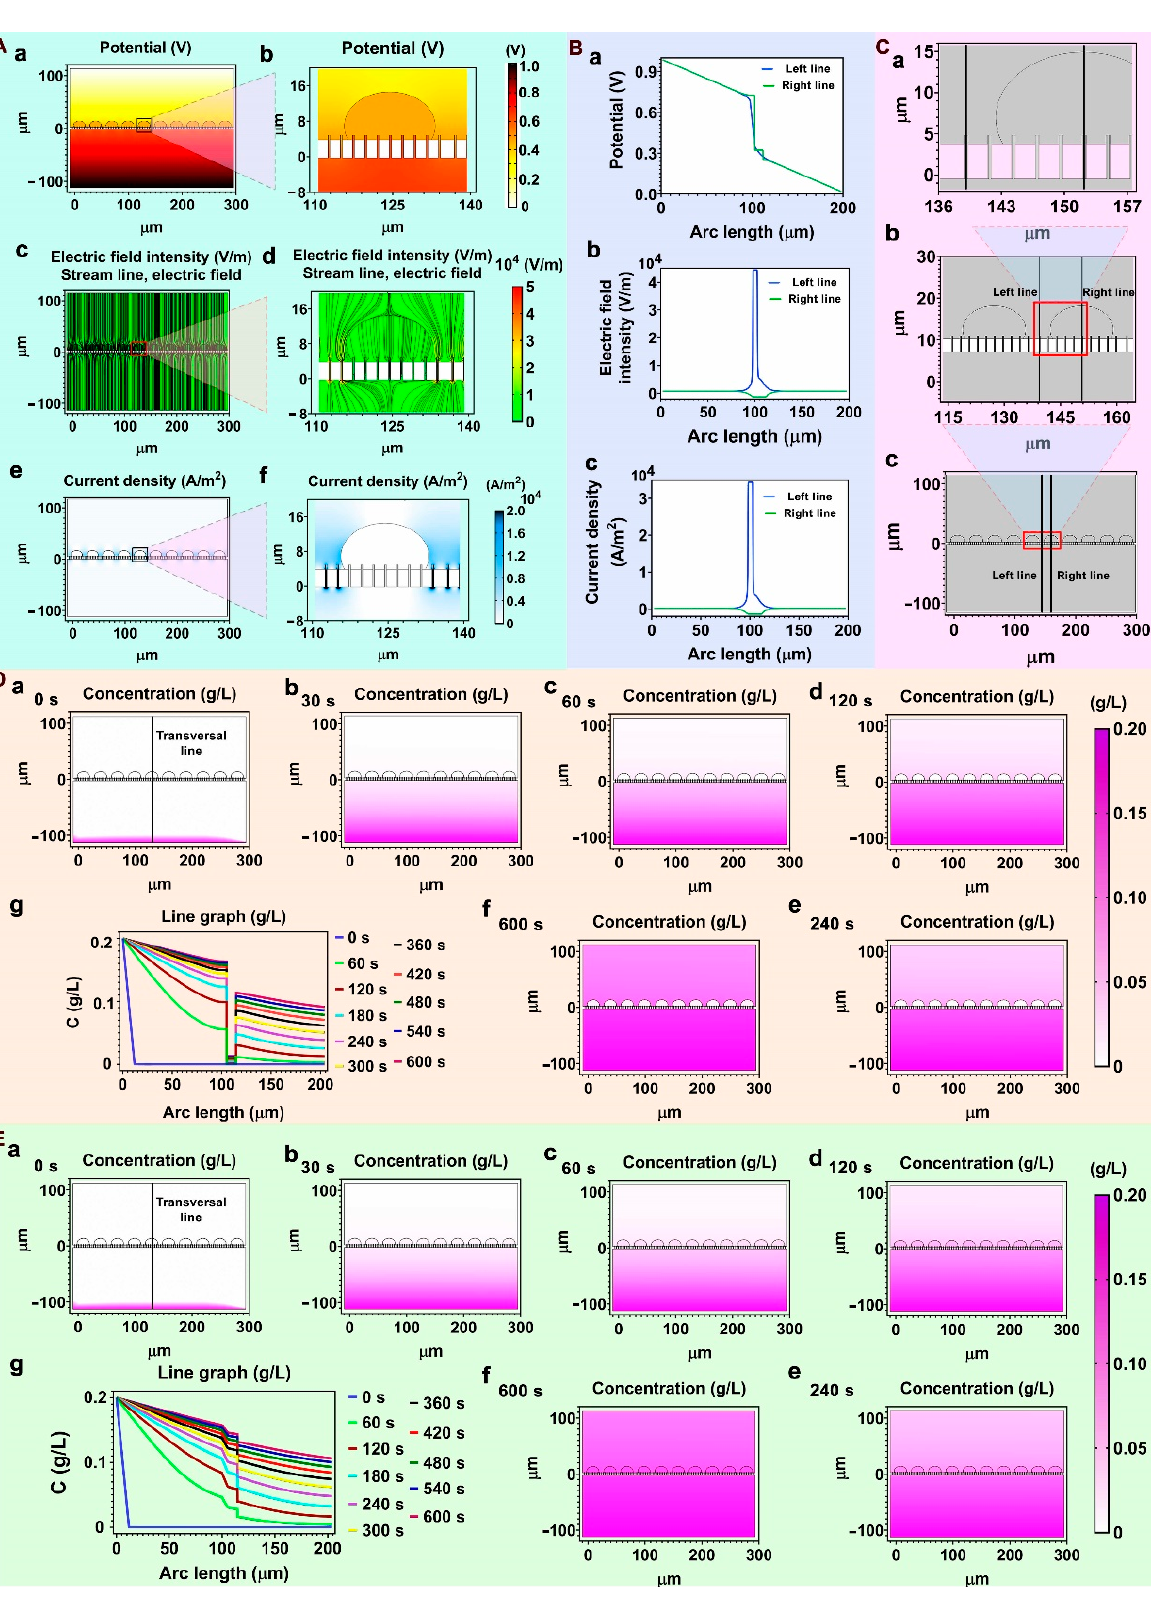
Prism 8.0 (GraphPad). All histograms and the corresponding error bars were presented as mean ± SD (standard deviation).